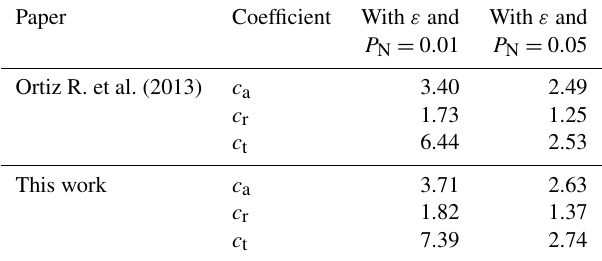
Table 1. Comparison of coefficients of fit equations for the arrival time, the reflection time, and the transition time, which have the tively (see Fig. 8). Paper Coefficient With ε and With ε and P N = 0 .